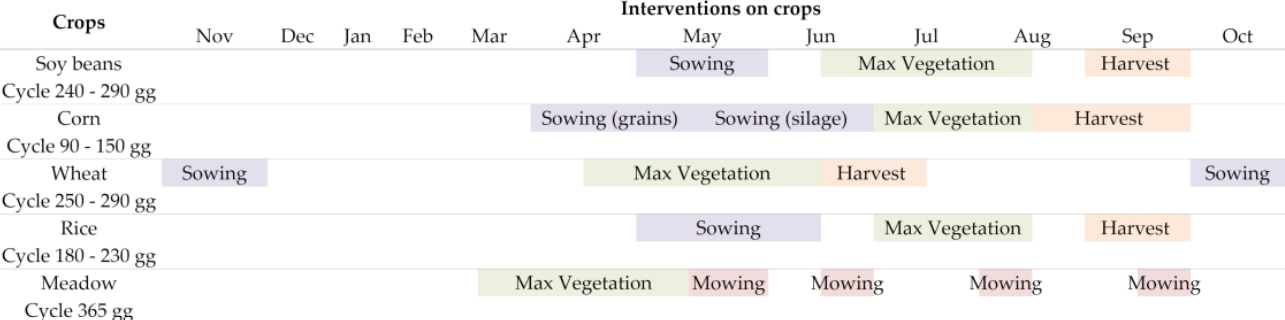
Figure 2. Example of the cultivation phases for the analyzed crops in the province of